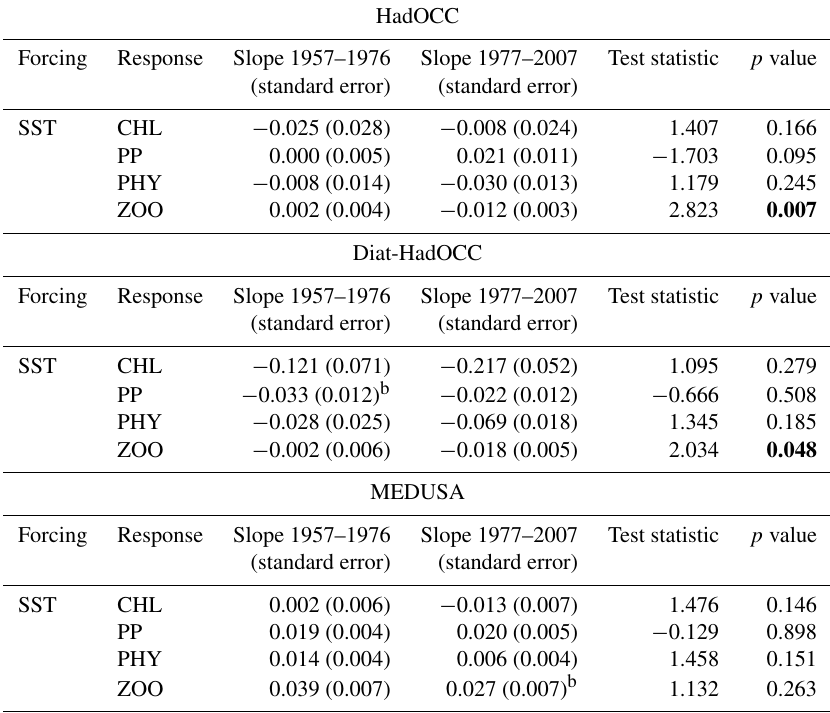
Table 5. Forcing–response regressions in HadOCC, Diat-HadOCC and MEDUSA with sea surface temperature (SST) as the physical forcing and surface chlorophyll (CHL), integrated primary production (PP), total surface phytoplankton (PHY) and zooplankton biomass (ZOO) as the responses. The slopes of the linear regressions between the forcing and response before and after the shift are compared using a test of equality of two regression slopes. Bold indicates significant slope differences ( p